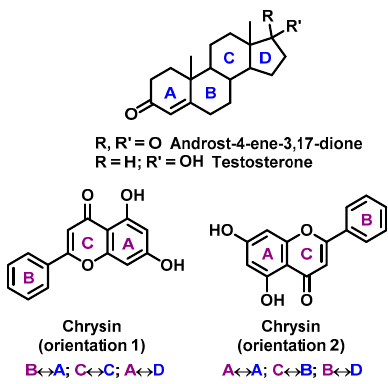
Figure 6. Chrysin mimic steroid core (rings in steroids are marked in blue, rings in chrisin in violet, with mutual rings overlapping).